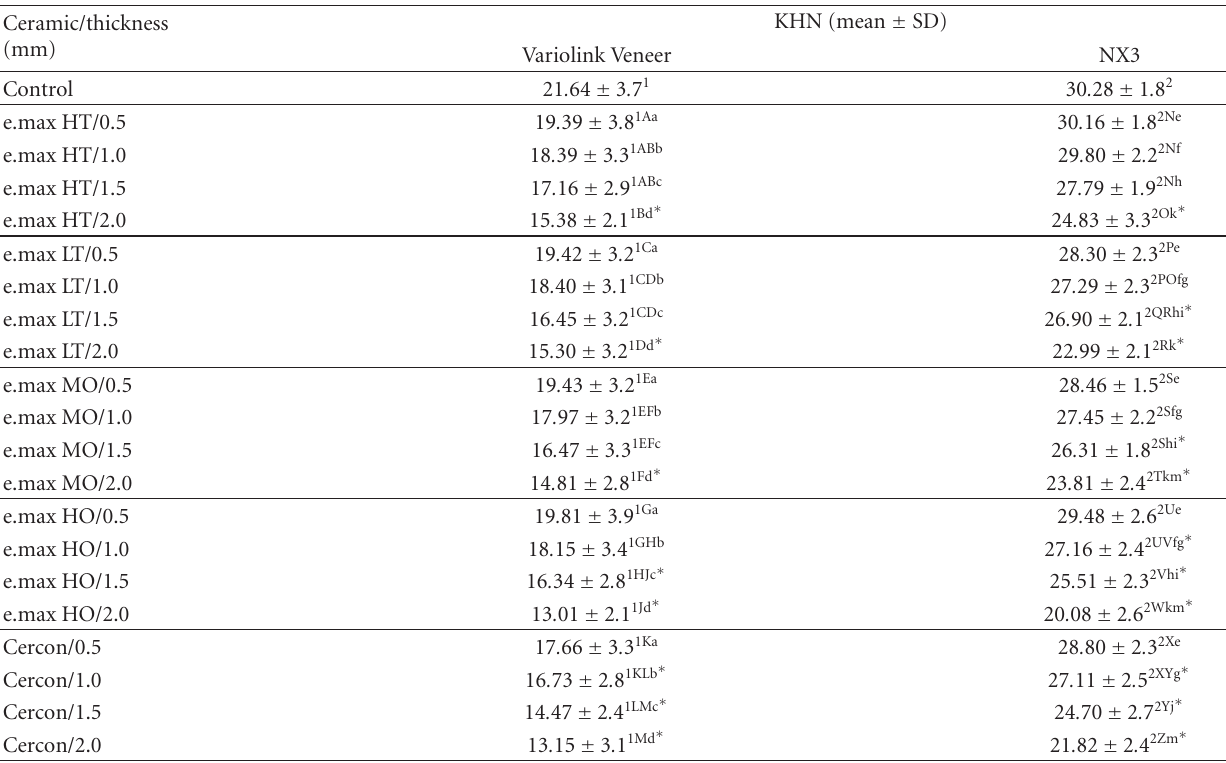
Table 1: The mean (KHN) ± standard deviation of surface hardness of two resin cements when polymerized under di ff erent ceramic a.